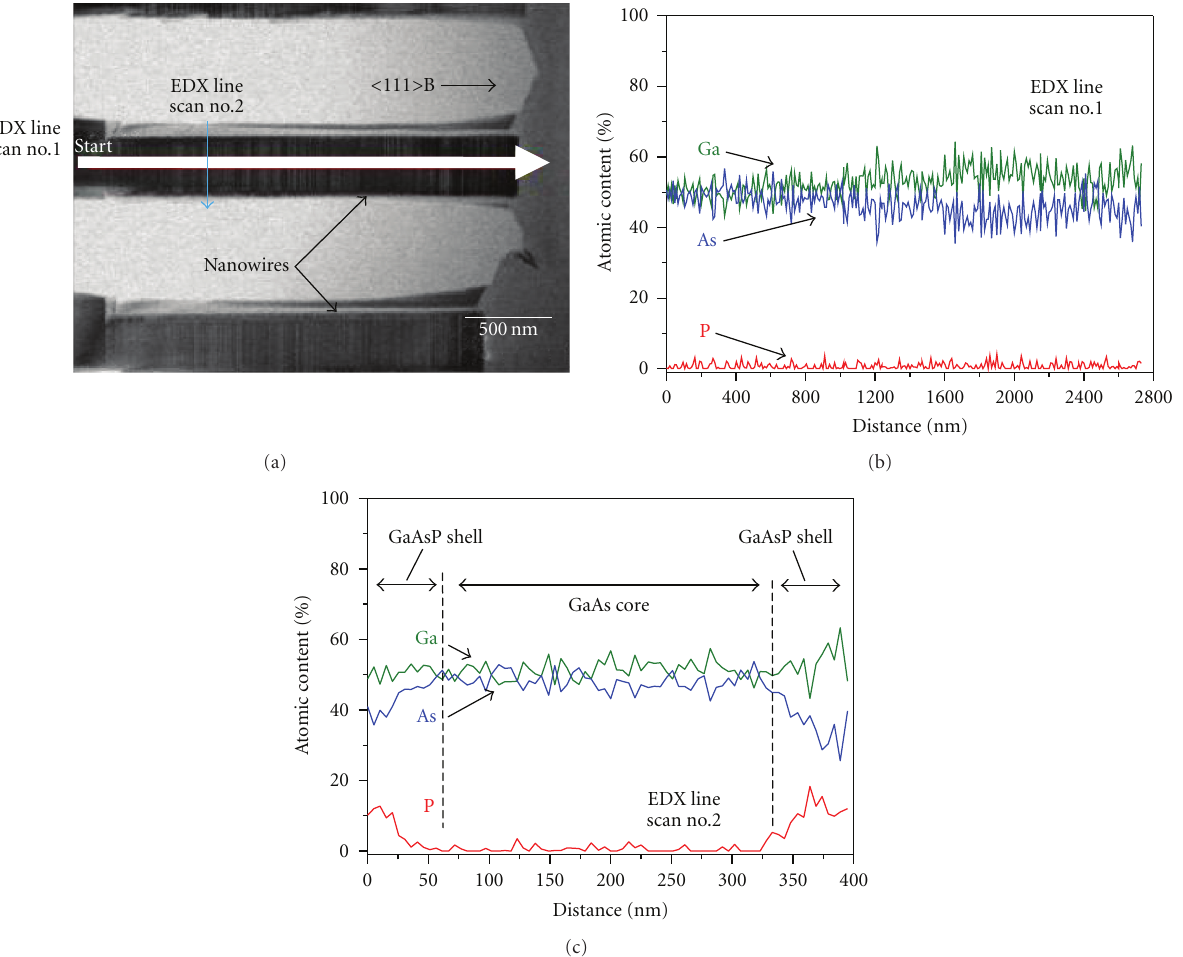
Figure 24: TEM/EDX analysis of GaAs/GaAsP nanowire. (a) Bright-field TEM image and axial/radial EDX line scans on nanowire. Axial plane of wire was exposed with FIB etching. (b) Variations in Ga (green), As (blue), and P (red) content for axial line scan no. 1 in (a). (c) Variations in Ga, As, and P content for radial scan no. 2 in (a). Radial EDX scan indicates that GaAs core is surrounded by approximately 50-nm thick GaAsP shell